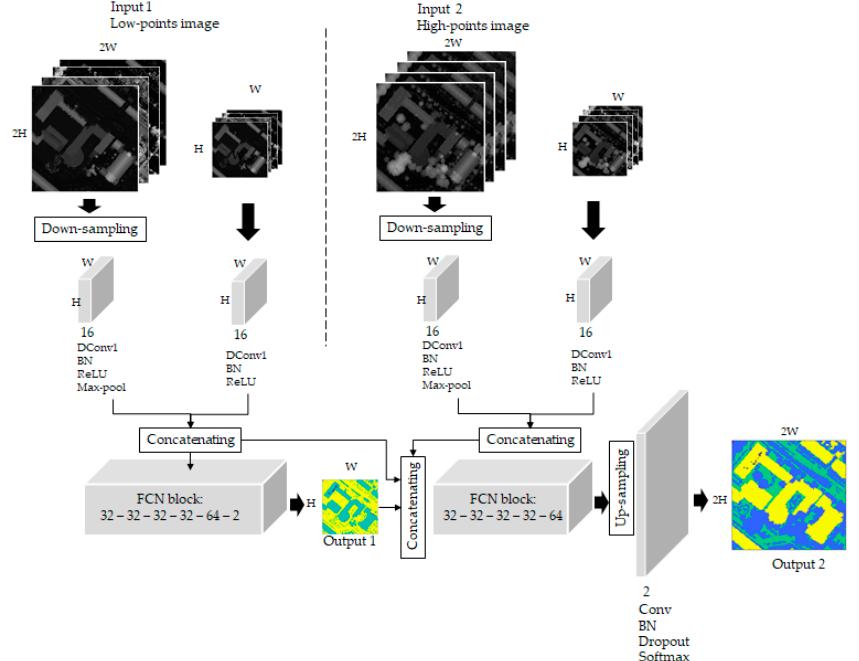
Figure 6. The proposed Multi-Task Network (MTN)-FCN network for multi-class classification on a point cloud dataset.